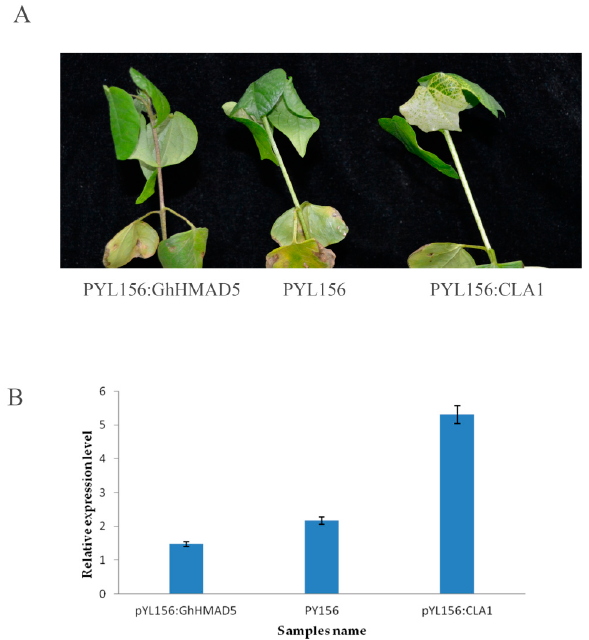
Figure 9. Phenotypic and expression analysis of 4 mM seedlings exposed to Cd stress and the control. ( A ) Phenotypic symptoms of cotton seedlings under 4 mM Cd stress for 9 h. ( B ) The expression analysis of GhHMAD5 gene of cotton seedlings under 4 mM Cd stress for 9 h.